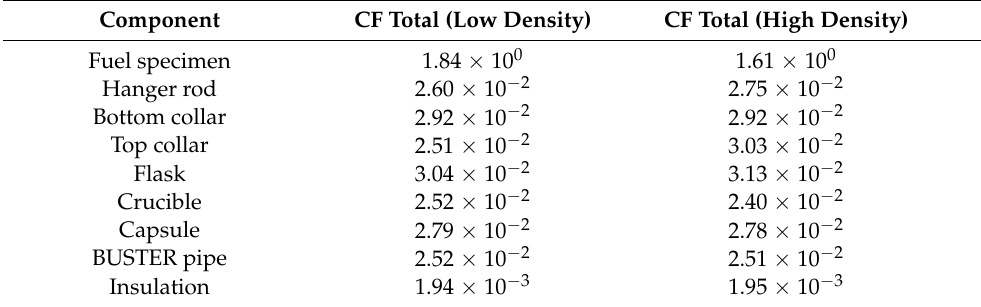
Table 3. Calibration factors for SIRIUS-CAL experiment components [46].